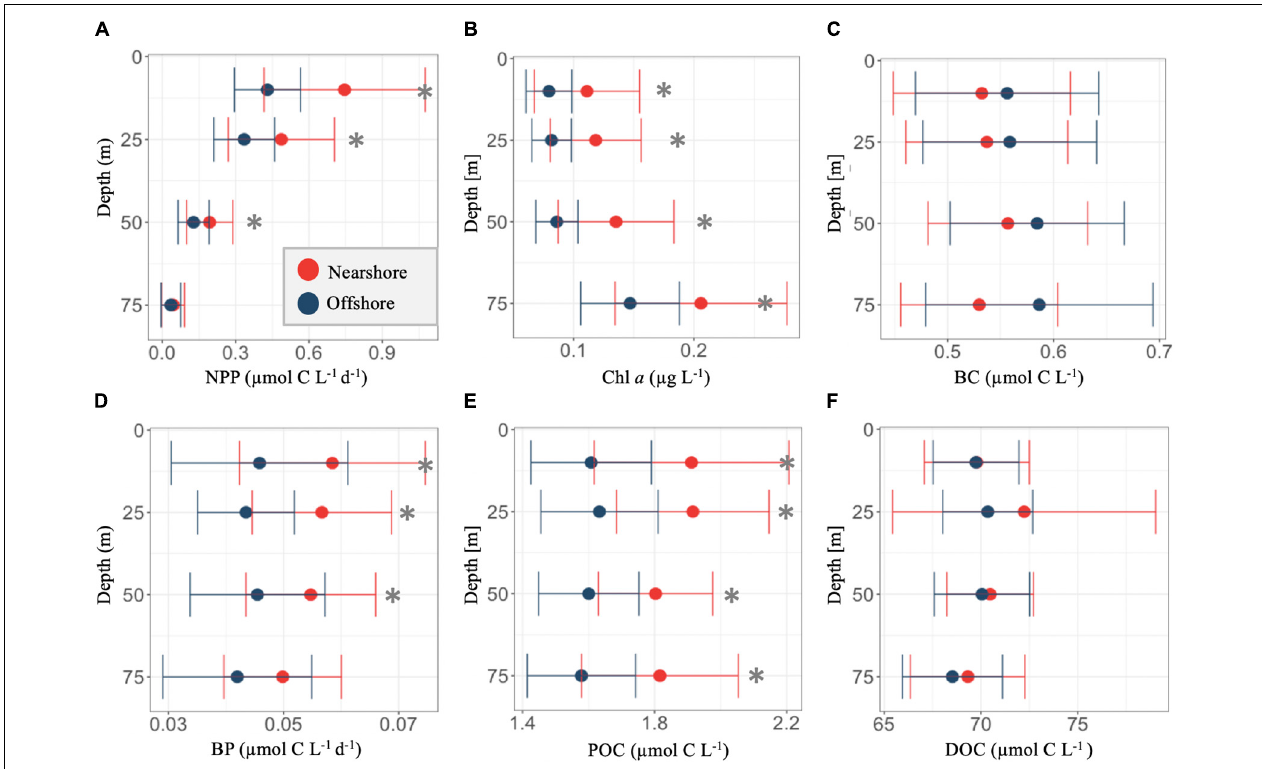
FIGURE 4 | Depth profiles of in the upper euphotic zone (0–75 m) of concentrations of net primary productivity (NPP; A ), chlorophyll a (Chl; B ), bacterioplankton carbon (BC; C ), heterotrophic bacterioplankton productivity (BP; D ), particulate organic carbon (POC; E ), and dissolved organic carbon (DOC; F ). Dark blue points indicated means ± SD for offshore stations, while red represents means ± SD for stations near Mo’orea. Asterisks denote significant differences ( p values < 0.05) in log(10)-transformed measured biogeochemical rates and concentrations as a function of station location (offshore versus nearshore). Statistical analysis was evaluated using a one-way analysis of variance